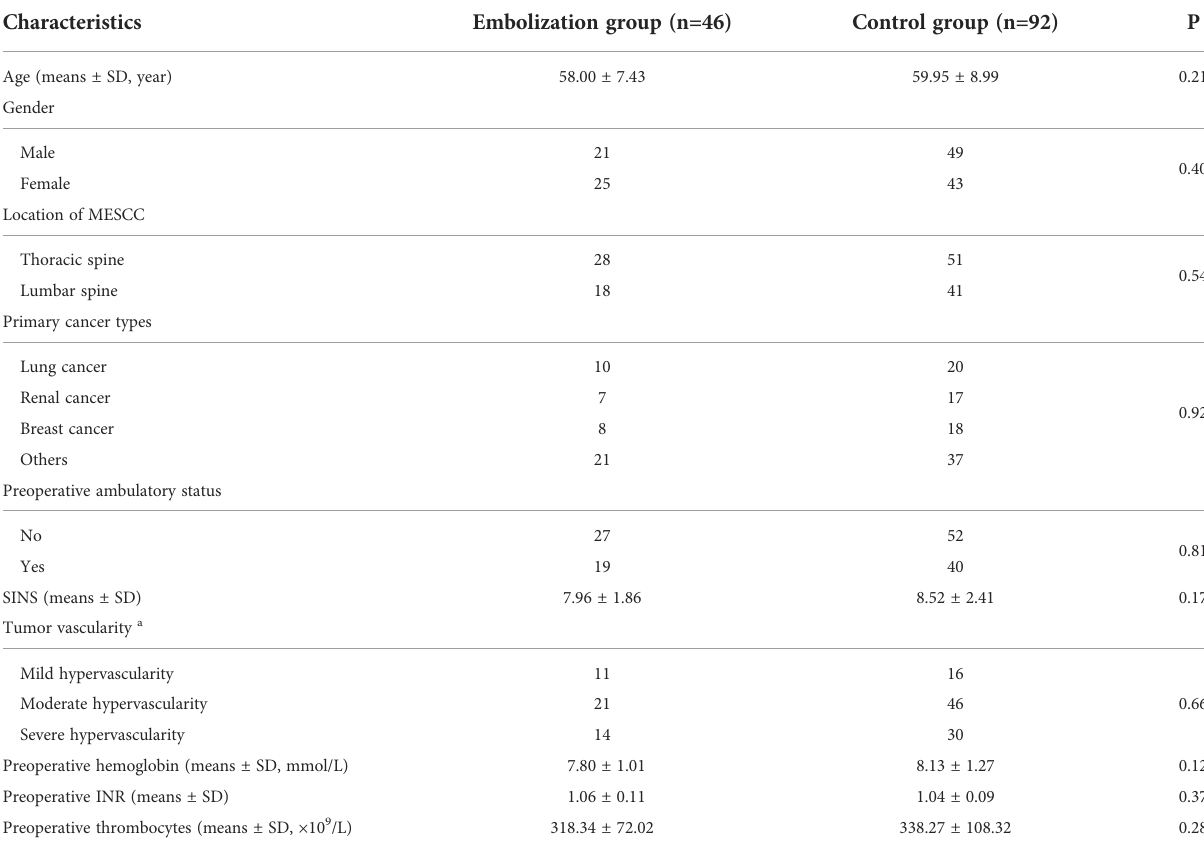
TABLE 1 Baseline clinical characteristics of the embolization and control